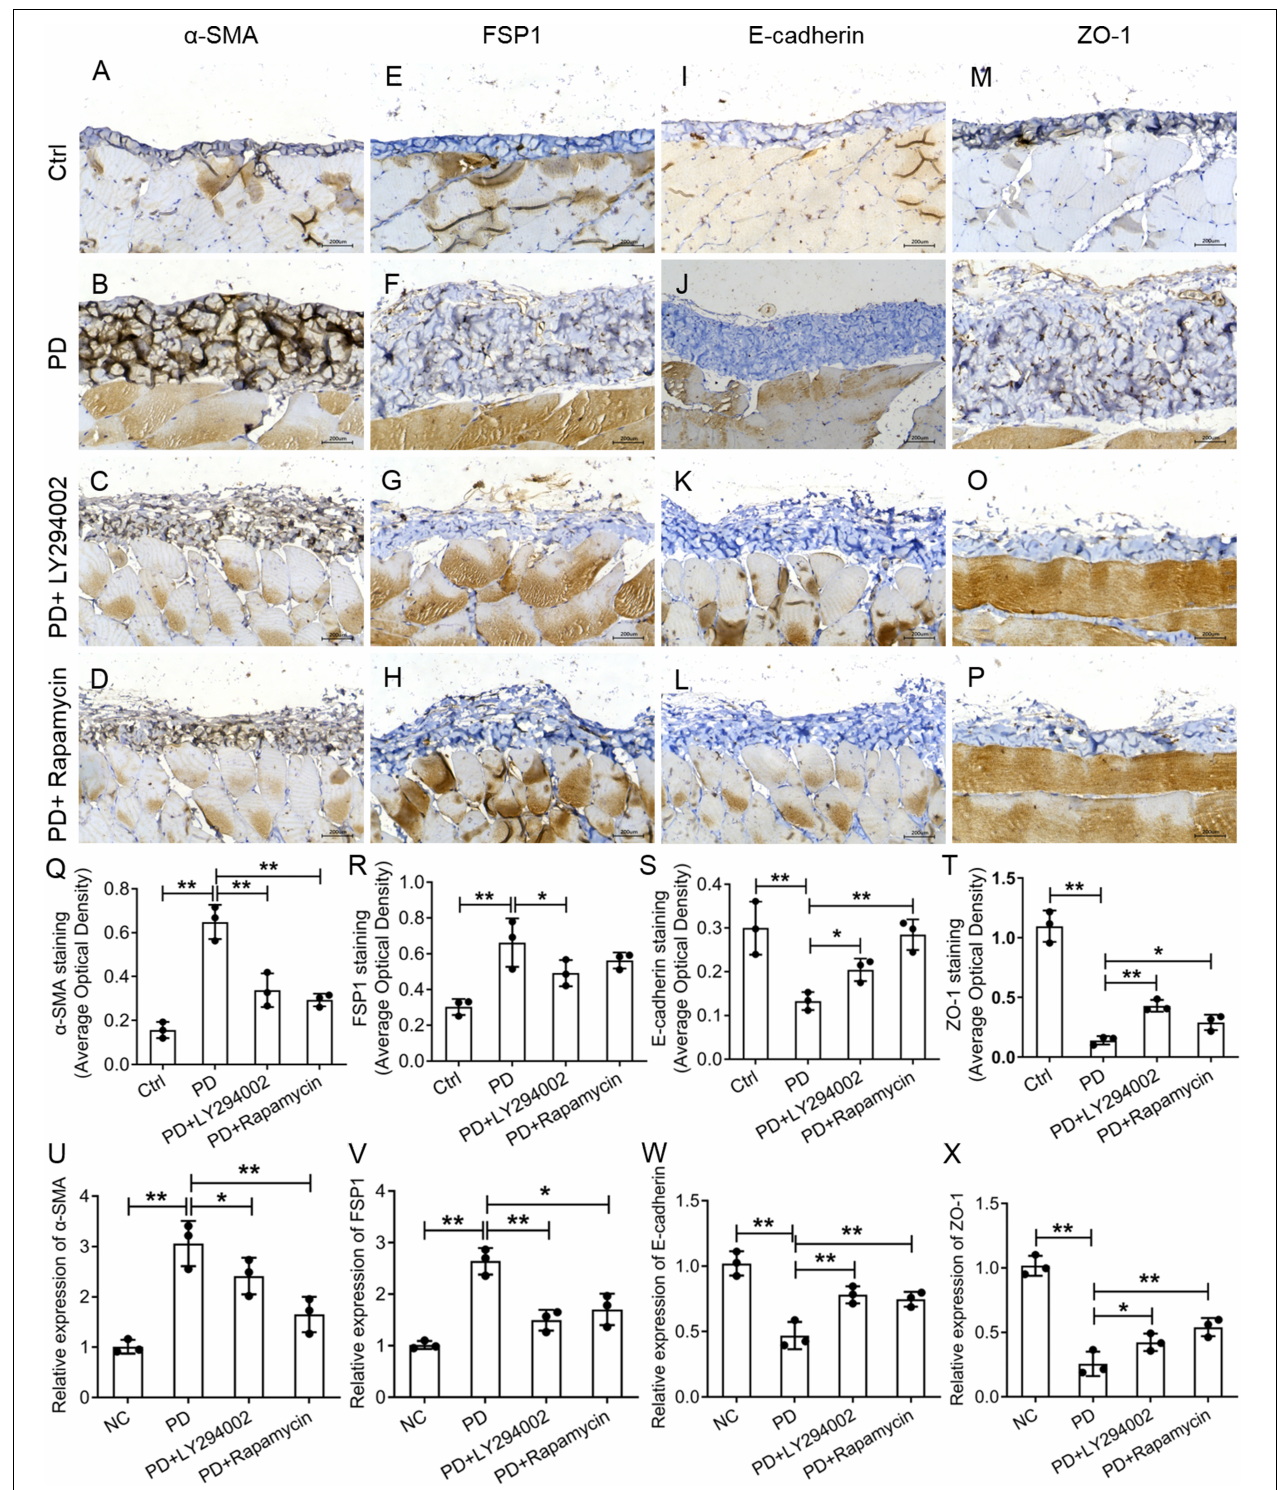
FIGURE 5 | Effects of LY294002 and rapamycin on HG-induced peritoneal fibrosis in rats. The expression of α -SMA (A–D) , FSP1 (E–H) , E-cadherin (I–L) and ZO-1 (M–P) in the peritoneum of control rats, PD rats and PD rats treated with LY294002 or rapamycin was determined by IHC assay. Three rats in each group